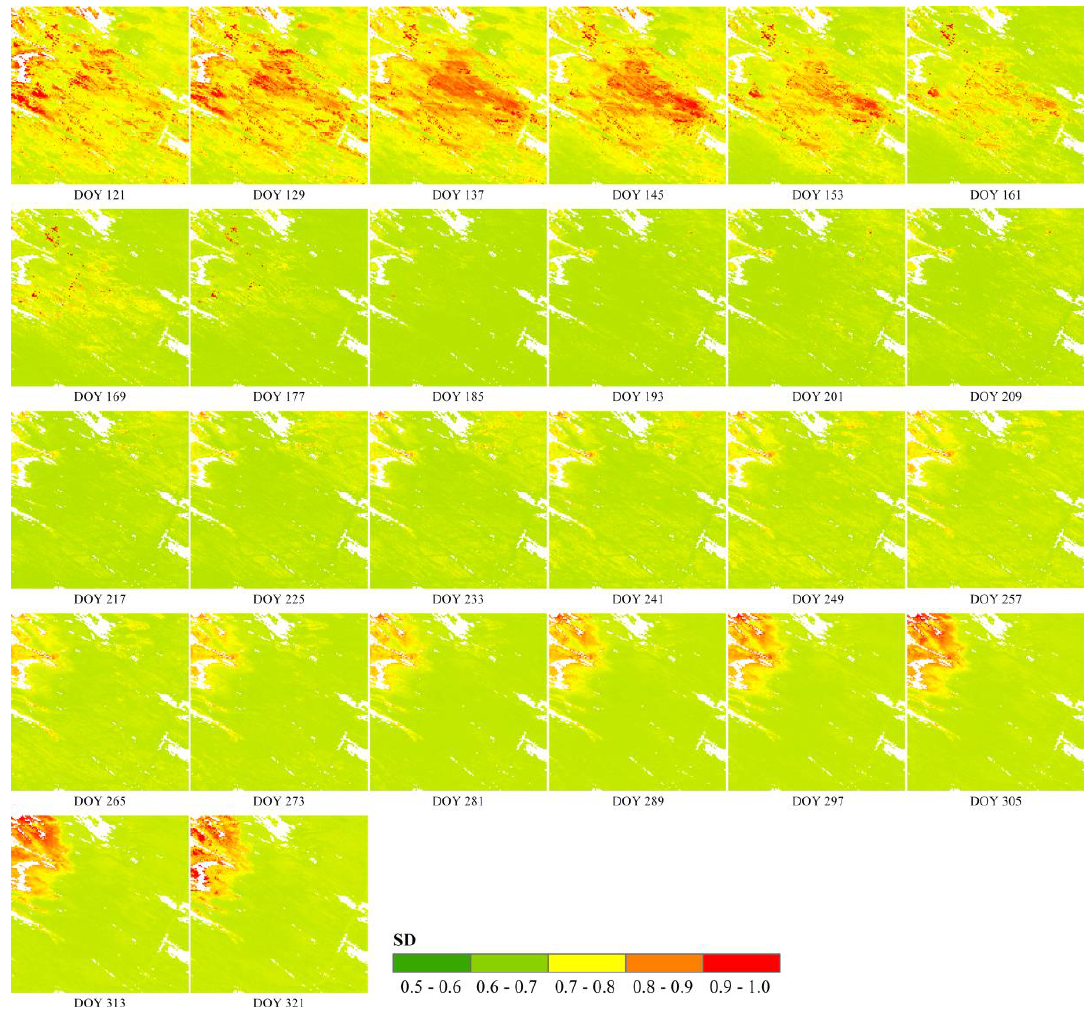
Figure 8. Maps of the standard deviation (SD) associated with the LAI retrievals (Figure 7). The white areas represent non-vegetated cover types.